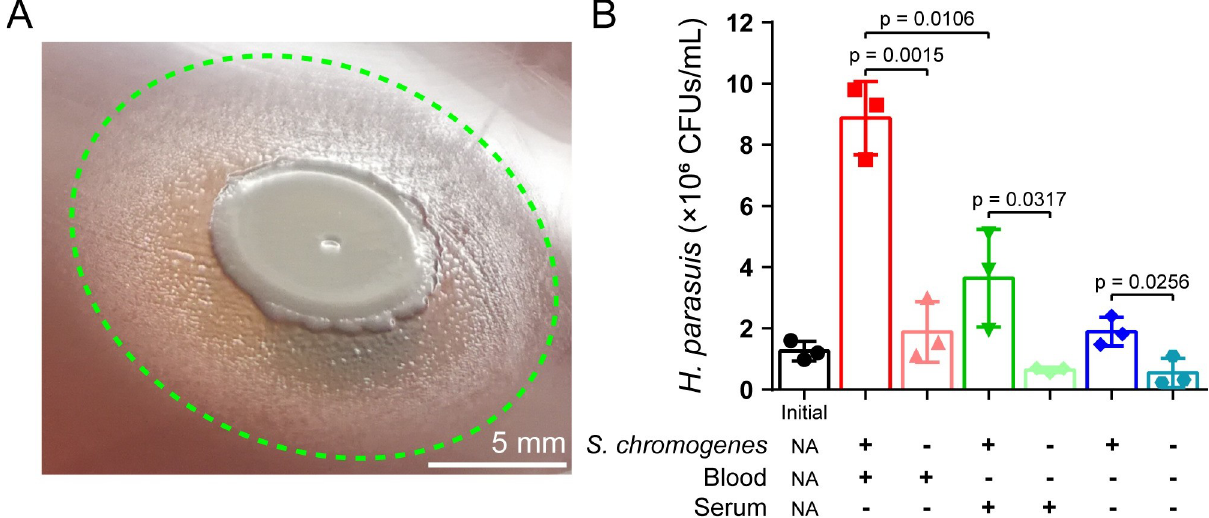
Fig 3. S . chromogenes supports the growth of H . parasuis in vitro . (A) Satellitism formed by S . chromogenes and H . parasuis after coculturing for 48 h. (B) H . parasuis displayed high density in the presence of S . chromogenes , together with either blood or serum. H . parasuis was monocultured or cocultured with S . chromogenes in TSB supplemented with different nutrients for 6 h. NA, not applicable. P values were determined by unpaired t -test. The mean of three biological replicates is shown, and error bars represent the standard deviation (SD) (n = 3).